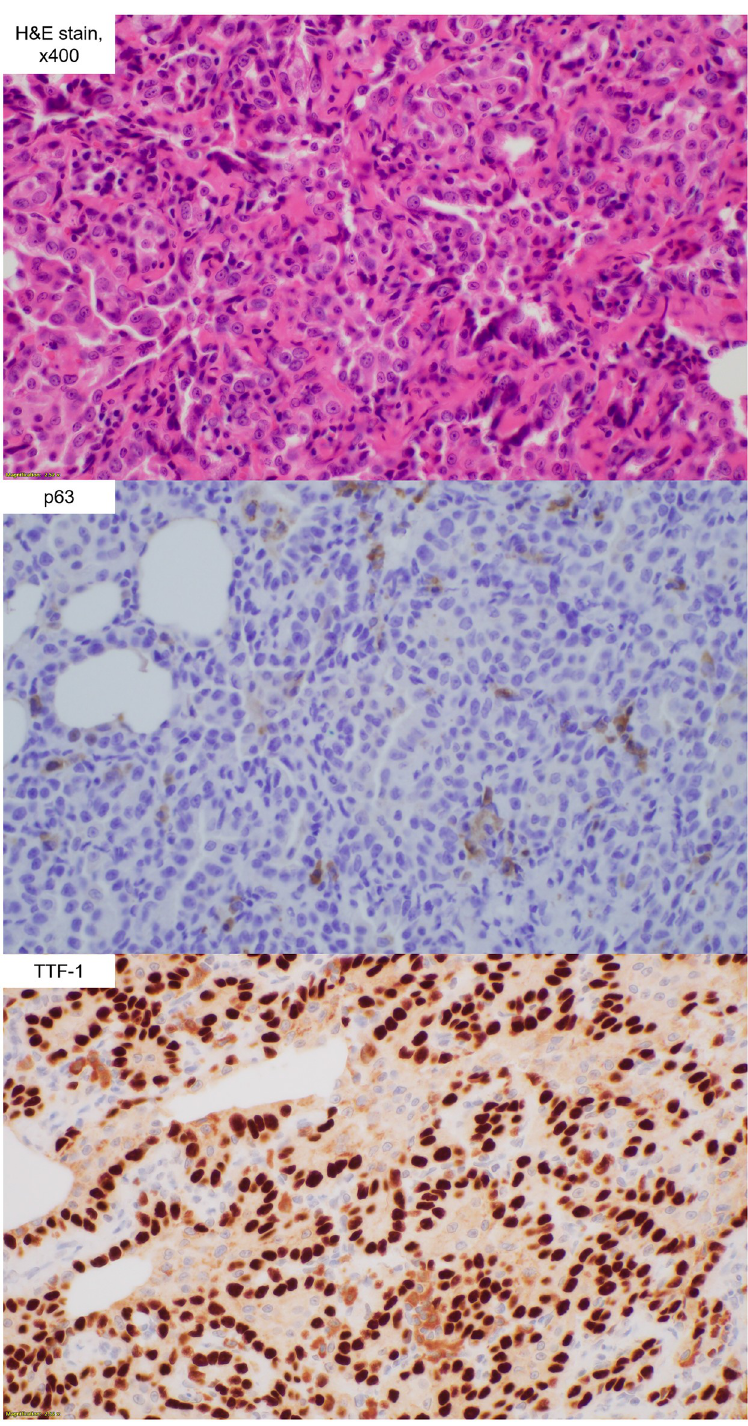
Fig 3. Histopathology (hematoylin and eosin stain, x 400) of adenocarcinoma. The adenocarcinoma tumor cells were positive for TTF-1 and negative for p63.